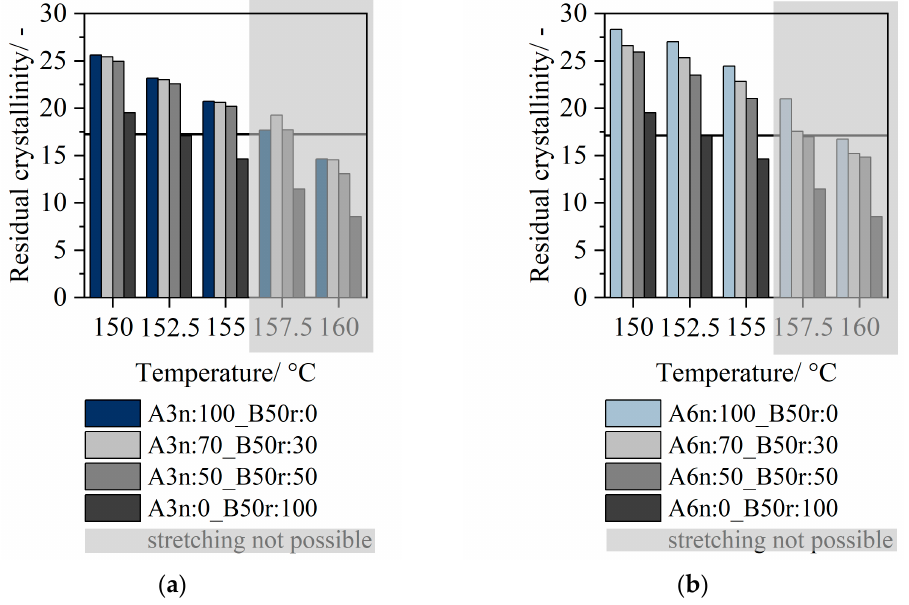
Figure 9 . Residual crystallinity of monolayer 3n and 50r as well as two-layer sheets in layer configuration A70_B30 and A50_B50 ( a ); residual crystallinity of monolayer 6n and 50r as well as two-layer sheets in layer configuration A70_B30 and A50_B50 ( b ).